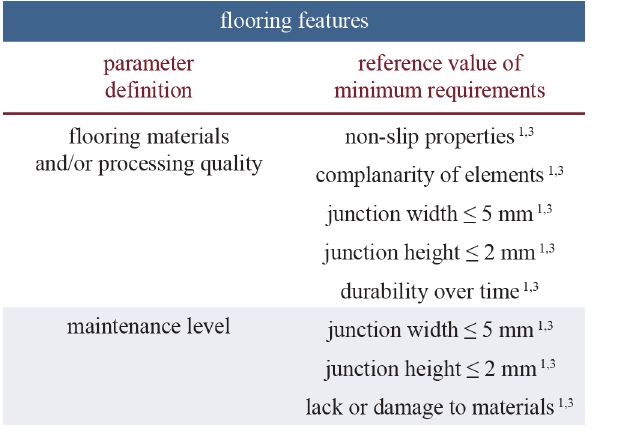
Table 2. Proposed parameters for the assess of flooring features. Sources are 1: Italian regulation, 3: literature and empirical investigation.